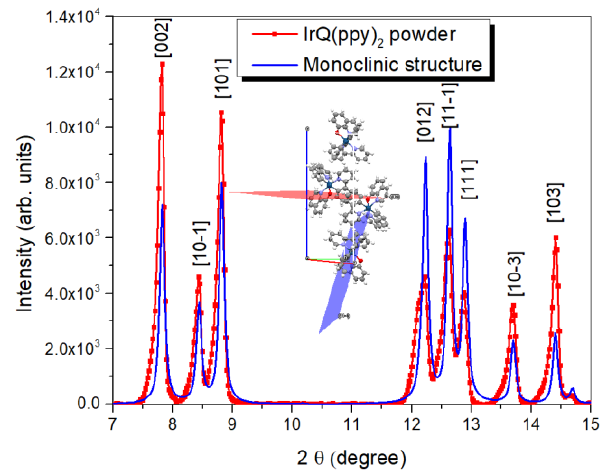
Figure 8. XRD patterns of the IrQ(ppy) 2 powder. Figure 8 . XRD patterns of the IrQ(ppy) 2 powder.